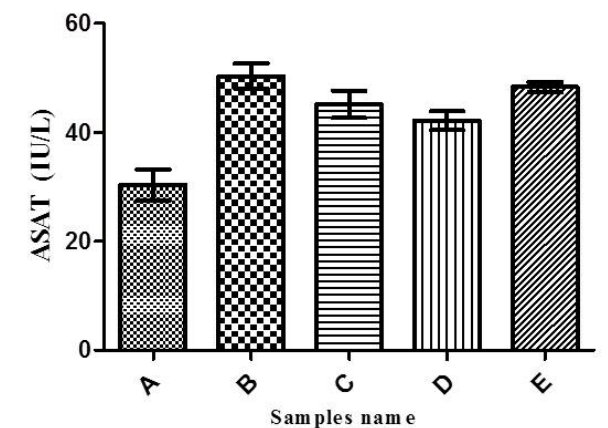
FIGURE 2 - ASAT content in serum samples following group, B: iron-overloaded mice, C: iron- overloaded mice receiving DFO, D: iron-overloaded mice receiving 30 mg/ kg/day naringin and E: iron- overloaded mice receiving 60 mg/kg/day